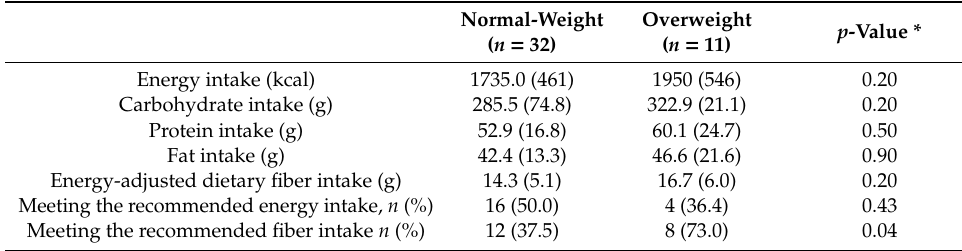
Table 2. Energy, macronutrient, and dietary fiber intake profile of study participants.